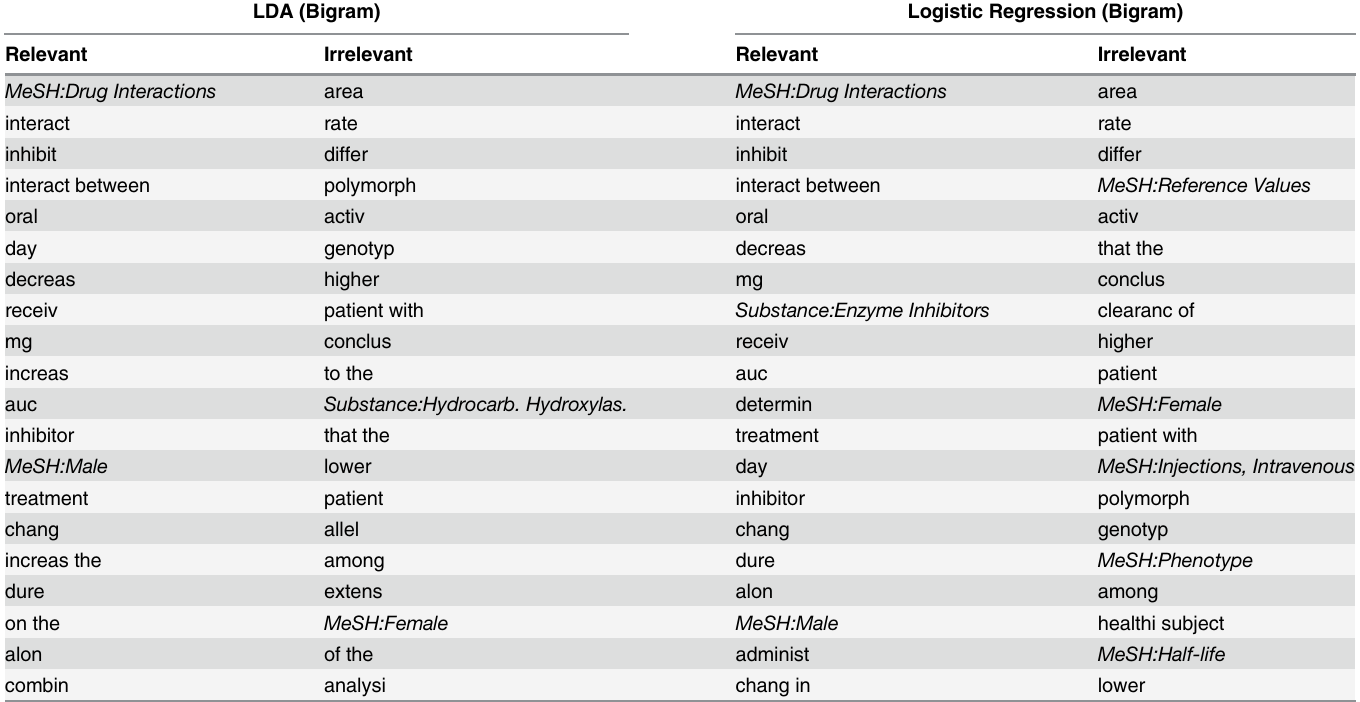
Table 2. Top 20 relevant and irrelevant abstract features. The stemmed textual features most discriminative of relevant and irrelevant classes on the ab- stract task, as chosen by two of the top-performing classifiers according to the RP3 measure: LDA with bigrams (left) and Logistic Regression with bigrams